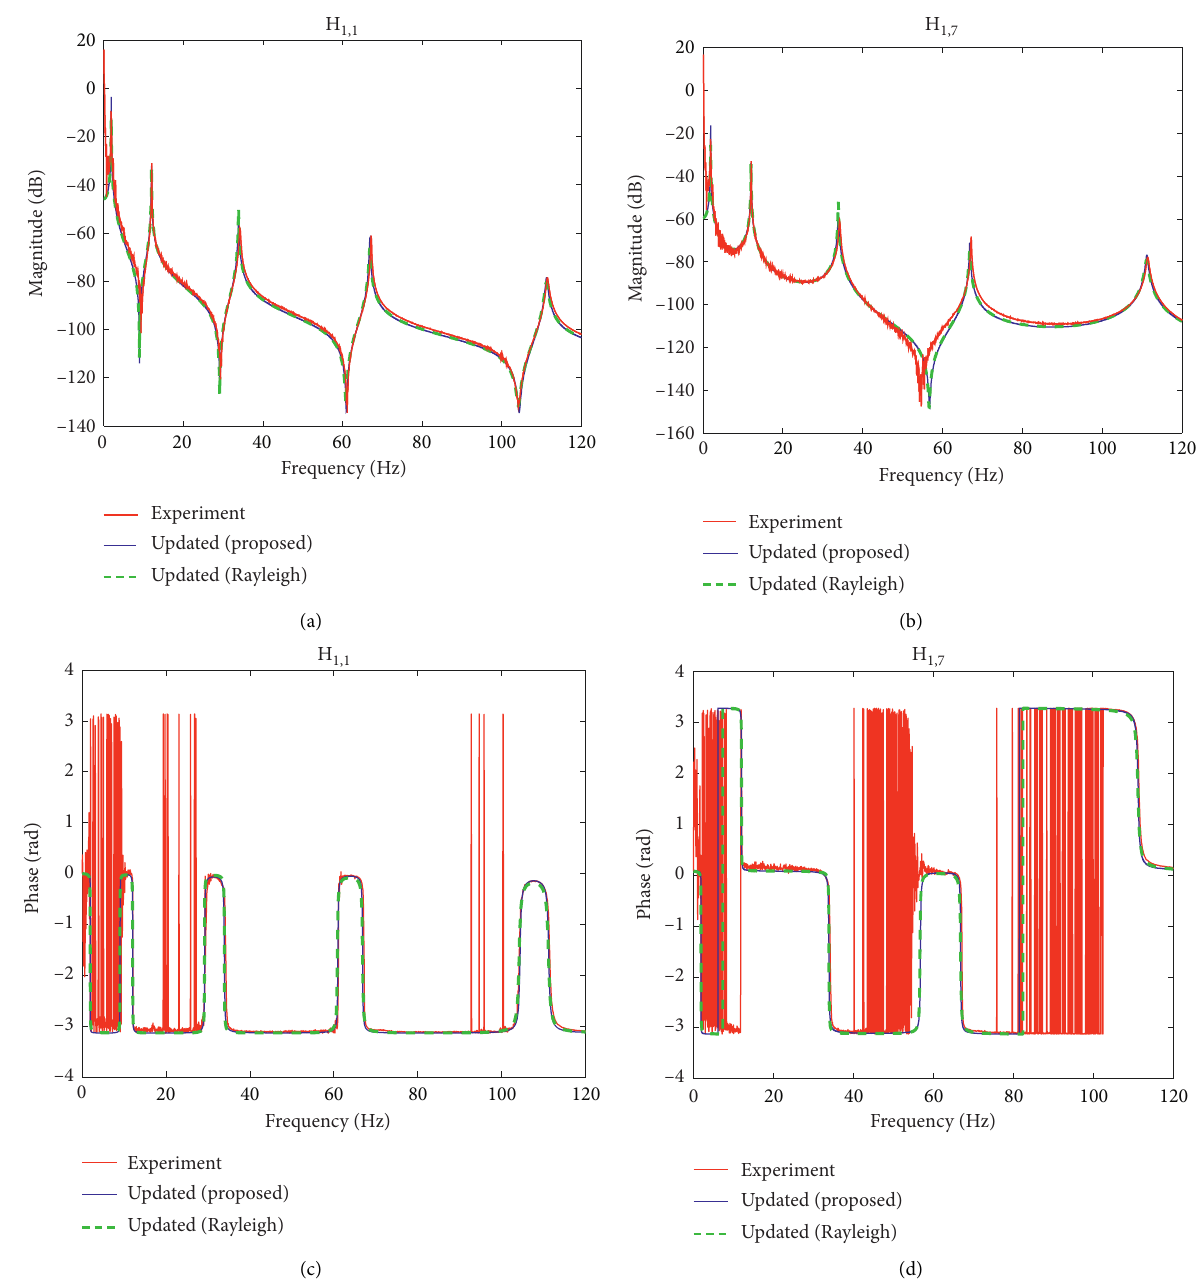
Figure 11: Comparison of experimental and updated analytical